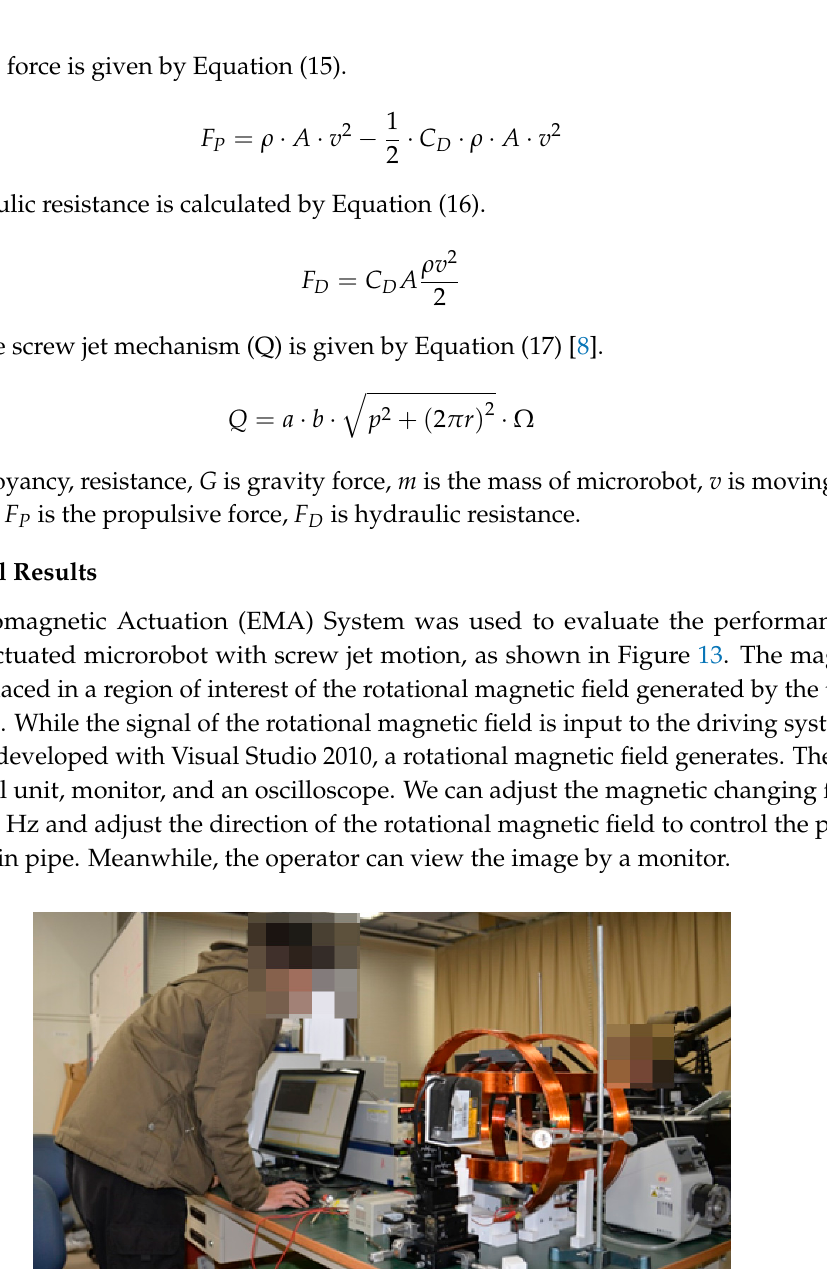
Figure 13. Experimental setup.